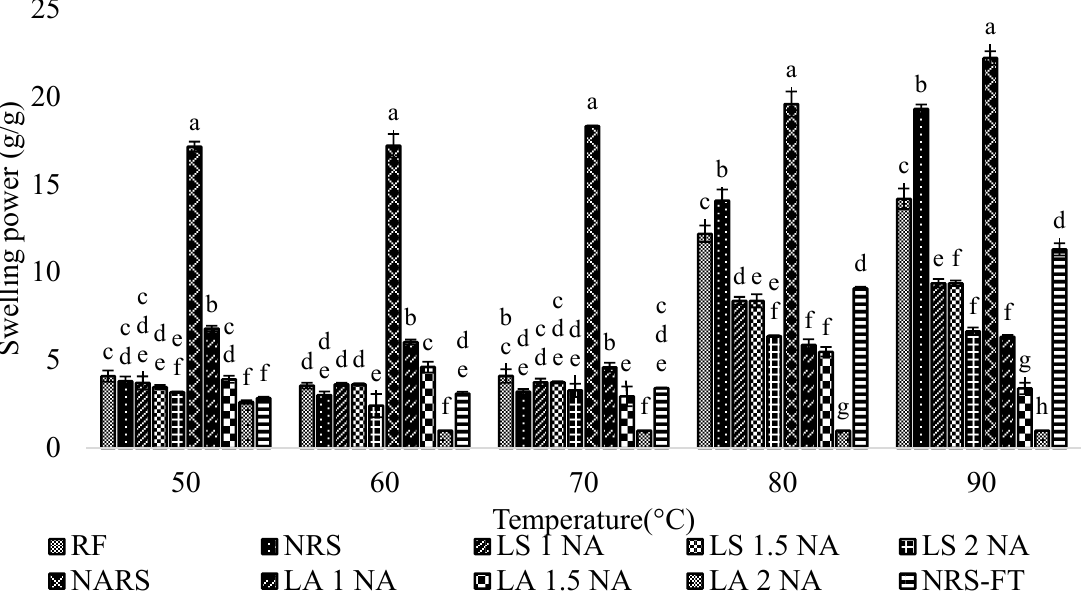
Figure 2. Swelling power of the Pathumthani 80 (RD 31) rice flour, native starch, and modified starches at a di ff erent temperature. Di ff erent su ffi x (a–h) within the same temperature indicate